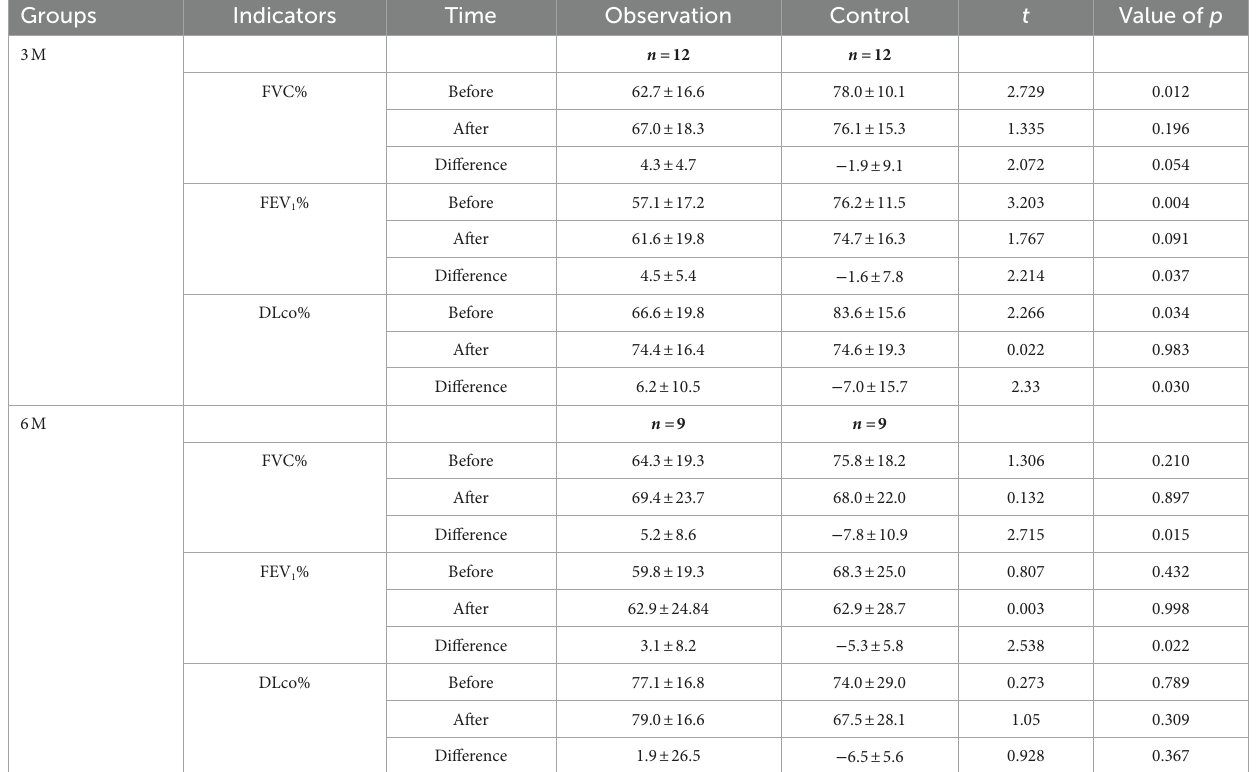
TABLE 3 Changes of pulmonary function indexes of the observation and control groups after treatment.